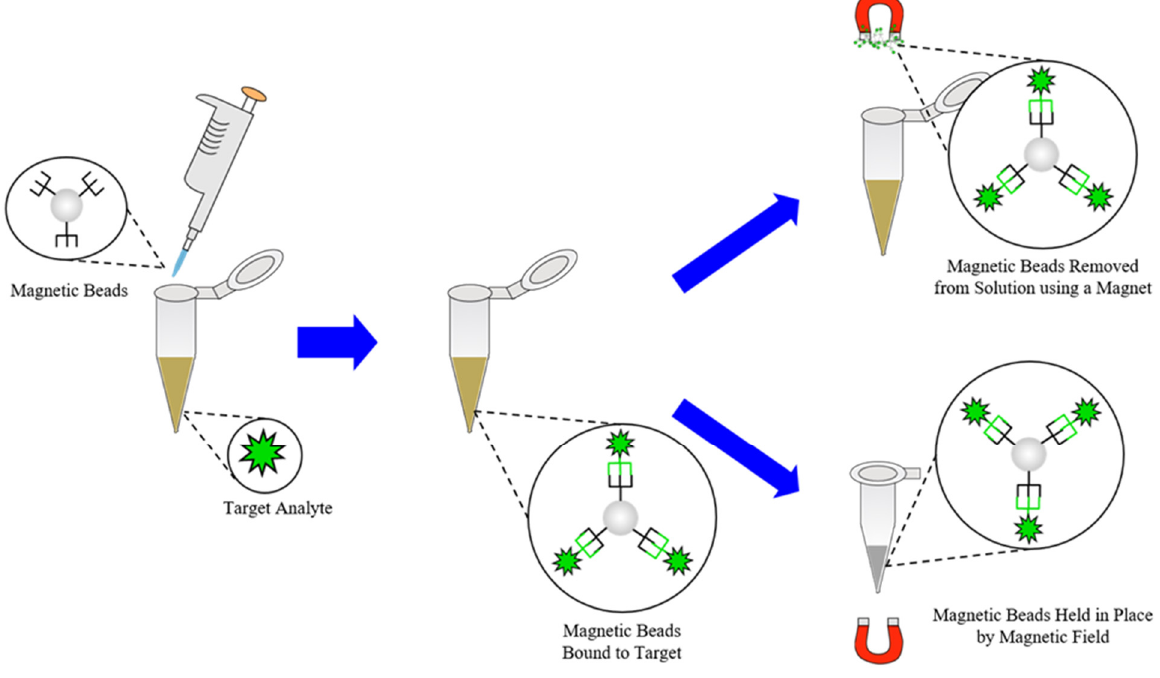
Figure 10. Magnetic bead-based extraction used for rapid separation or magnetic pelleting of target analytes. Paramagnetic